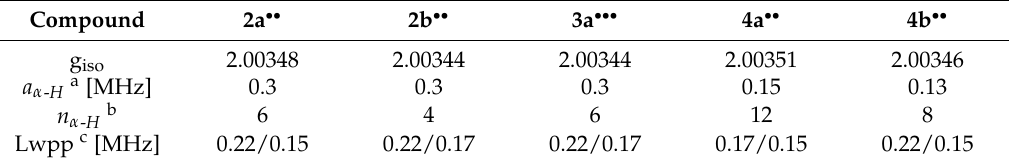
Table 1. Simulation Parameters for the room temperature EPR spectra of 2a •• , 2b •• , 3a ••• , 4a •• , and 4b •• . The coupling to the 13 C nuclei and exchange coupling constants are discussed in the text. Compound